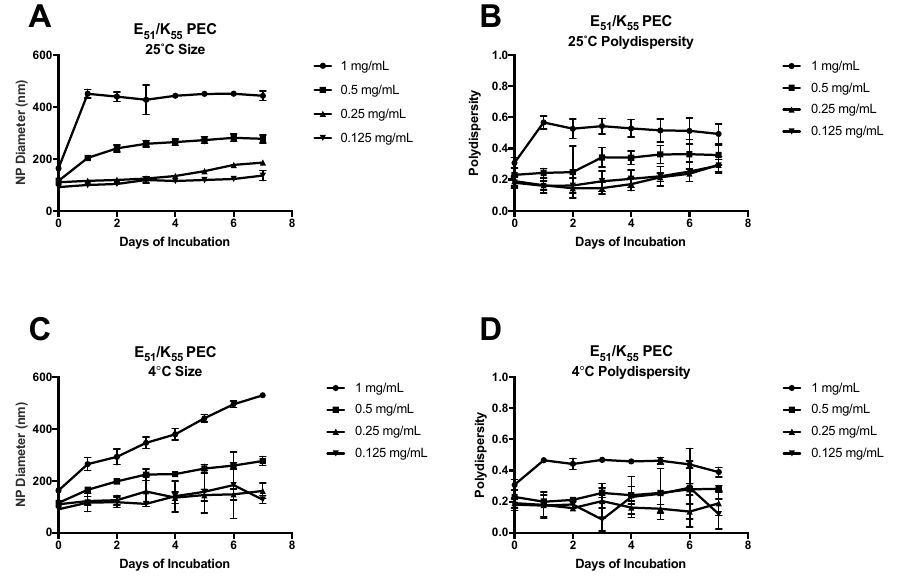
Figure 3. Stability of E 51 /K 55 PEC formed from 1:2 charge ratio at 25 ◦ C and 4 ◦ C. Panels ( A , B ) show the size and polydispersity, respectively, of PEC formed from E 51 and K 55 at a 2:1 charge ratio at 25 ◦ C over 7 days. At 1 mg/mL and 0.5 mg/mL there was an increase in size after 24 h of incubation, followed by plateau. There was little change in polydispersity. The 0.25 and 0.125 mg/mL formulations showed little change in diameter or polydispersity over 7 days; Panels ( C , D ) show the size and polydispersity, respectively, of PEC formed from E 51 and K 55 at a 2:1 charge ratio at 4 ° C over 7 days. All formulations except 0.125 mg/mL showed a gradual increase in size over 7 days. The 0.125 mg/mL formulation showed no significant change in diameter during the 7 day incubation. The 1 and 0.5 mg/mL formulations increased in polydispersity for three days before reaching a plateau, while the 0.25 and 0.125 mg/mL formulations remained stable until day 7, where there was an increase in the polydispersity. Data were obtained by DLS, and are displayed as averages over 3–4 wells ± standard deviation.